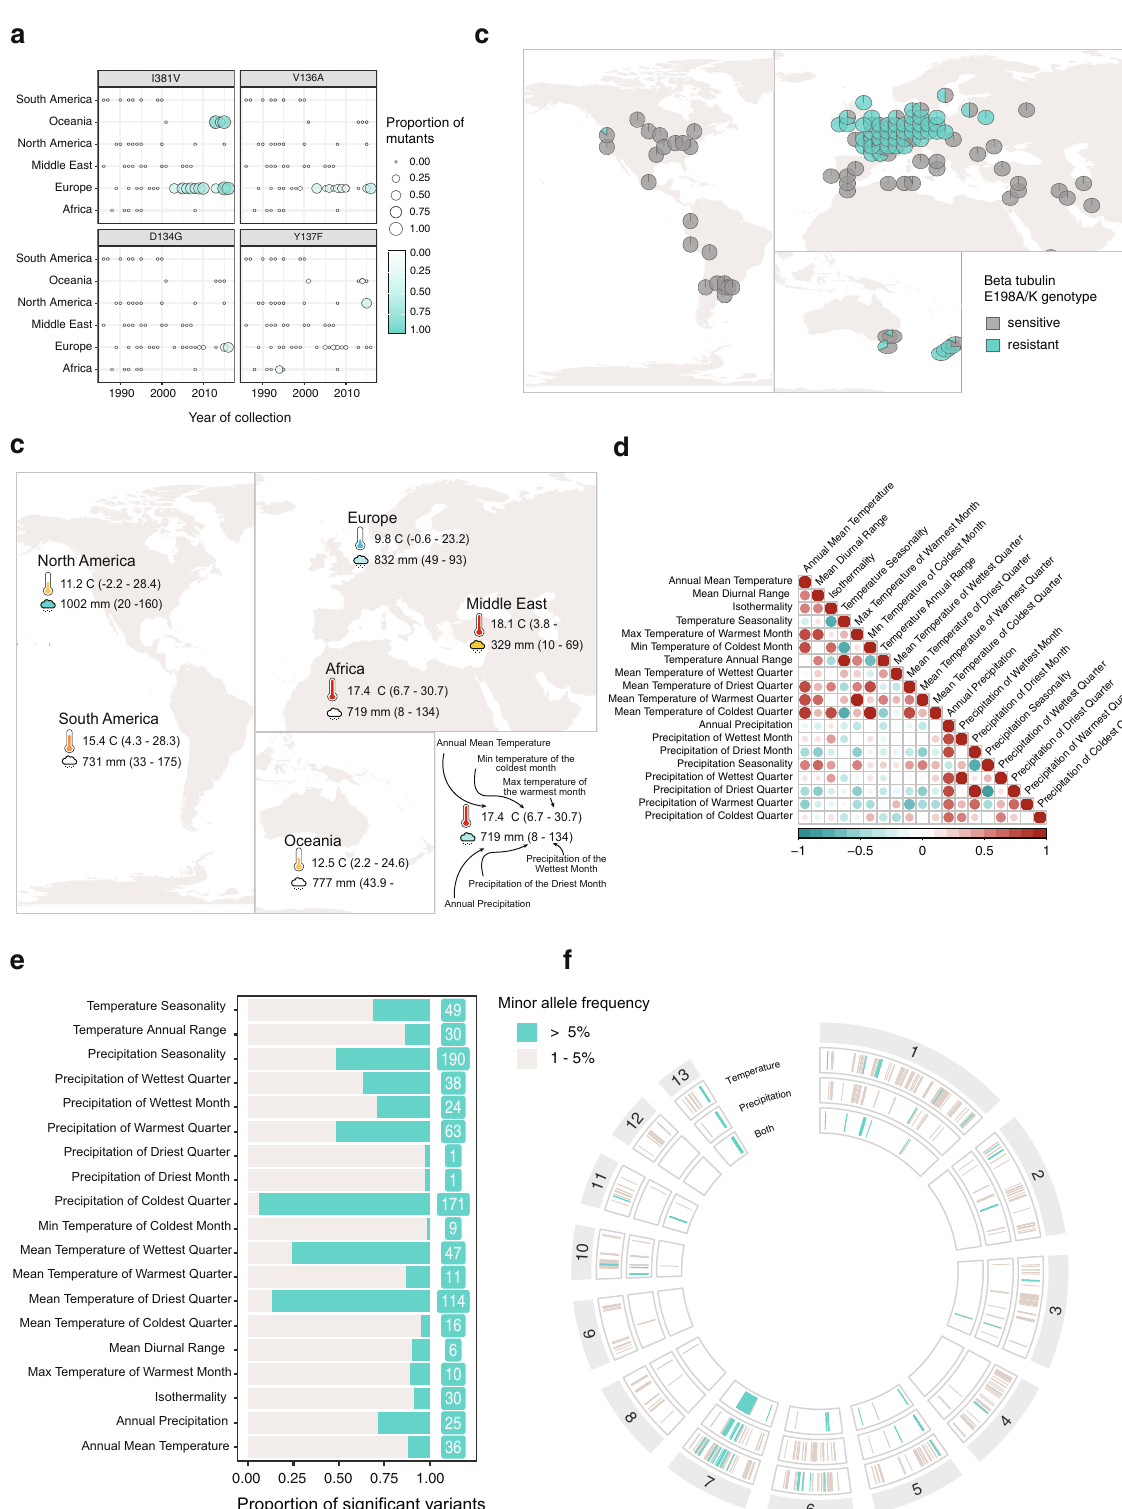
analyzed bioclimatic variables. e Proportion and number of variants signi fi cantly associated with each bioclimatic variable and with a minor allele frequency (MAF) higher than 5%. f Genomic location of variants signi fi cantly associated with the bioclimatic variables grouped into three main categories (variables describing temperature, precipitation levels, and variables describing combined measures of temperature and